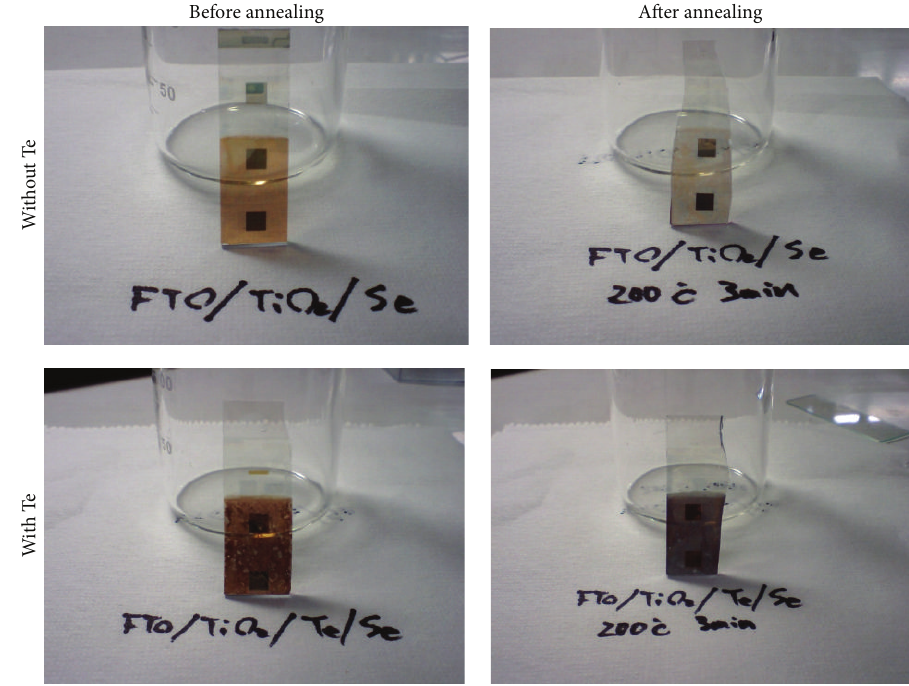
Figure 4: Photographs of selenium-deposited electrodes with and without tellurium and before and after annealing at 200 ∘ C for 3